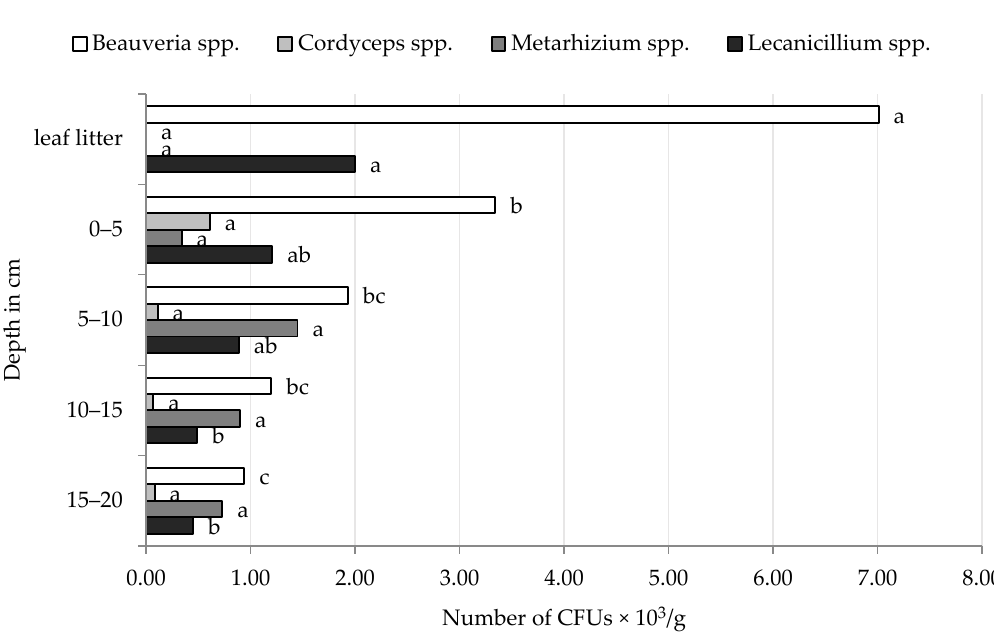
Figure 1. Average density of CFUs of entomopathogenic fungi in the leaf litter and individual layers of forest soils collected in Golice. ab Statistically significant differences between the concentration of CFUs of entomopathogenic fungi depending on the soil depth.